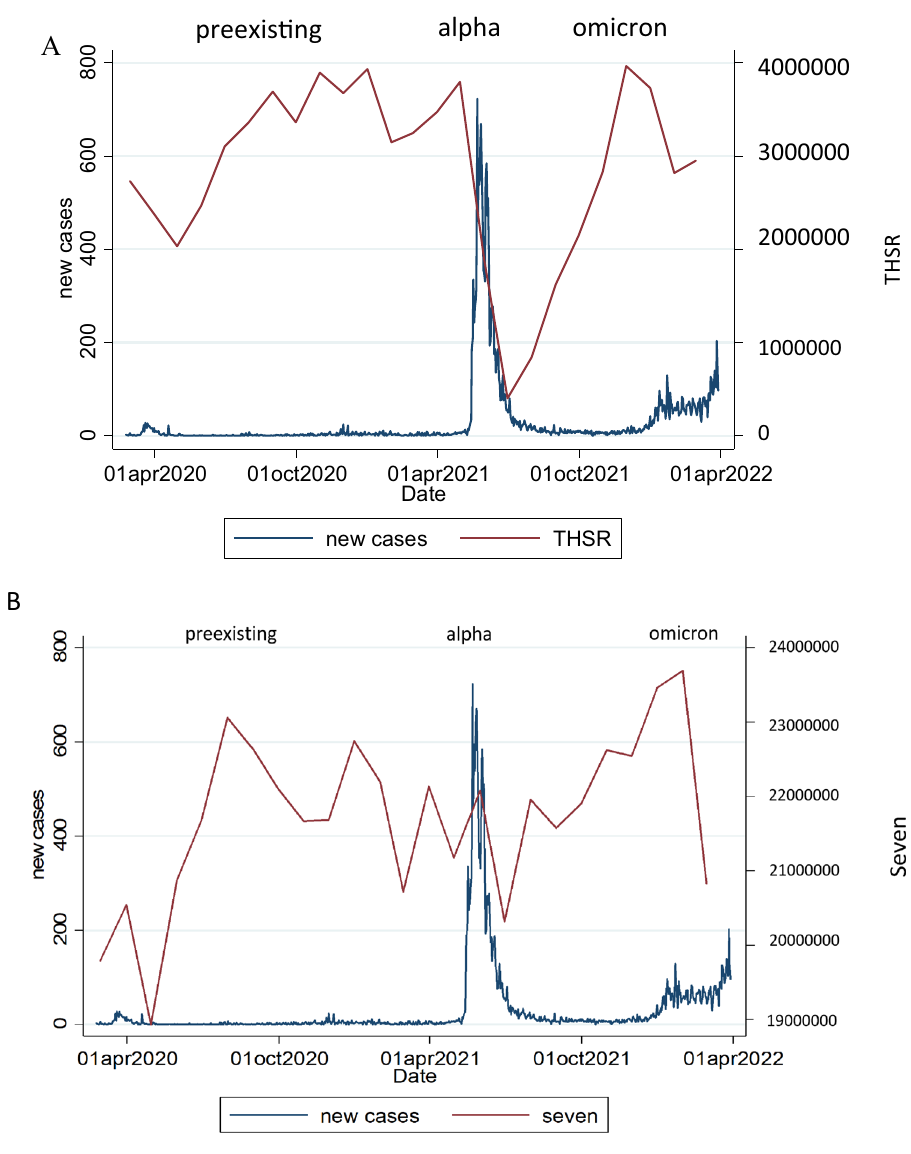
Figure 2. Relationship of daily number of new confirmed COVID-19 cases per million people (7-day rolling average) with the monthly operating income of ( A ) THSR and ( B ) 7-Eleven